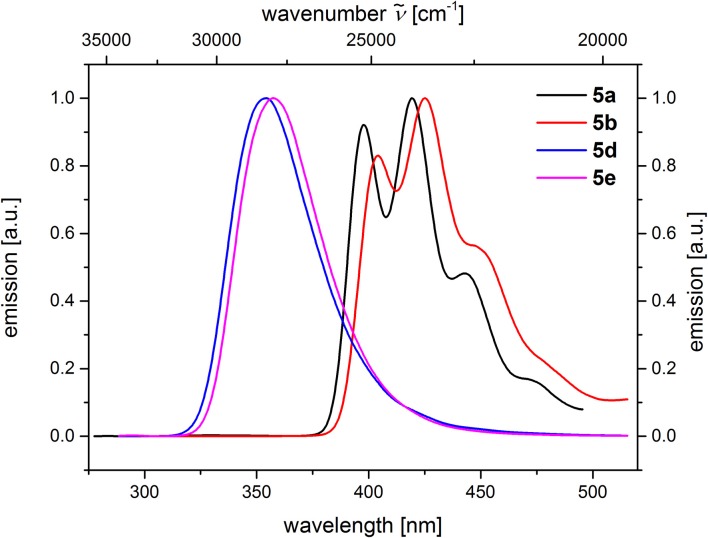
Comparison of emission spectra of compounds 5a and 5b (c(5) = 10−5
m, λexc = 268 nm), as well as compounds 5d and 5e (c(5) = 10−4
m, λexc = 258 nm) (recorded in CH2Cl2 (chromasolv), T = 298 K).